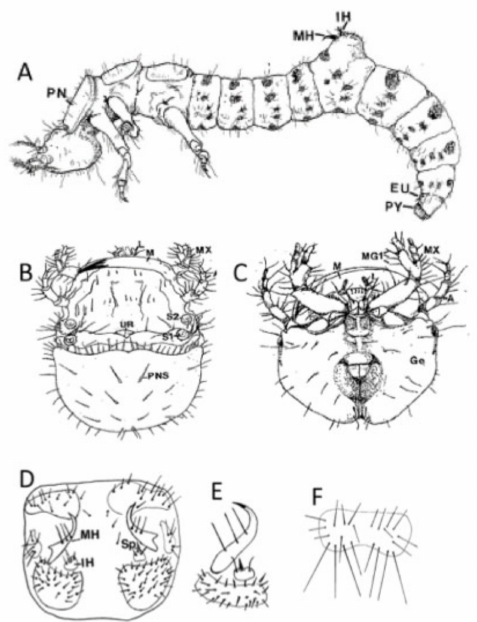
Figure 3. ( A ) Tiger beetle larva showing key characters: PN, pronotum; MN, median hooks; IH, inner hooks; EU, ninth eusternum; PY, pygopod. ( B ) Head, dorsal view, ( C ) ventral view: M, mandible; S1, stemmata I; S2, stemmata II; U, U-shaped ridge of frons; PNS, pronotal setae; MG1, galea of maxilla (for determining instar); MX, maxilla; A, antenna; Ge, gena; L, labium. ( D ) Dorsal view of fifth abdominal segment showing hooks Nin, sclerites, and setae. ( E ) Median and inner hooks and fifth caudal sclerite. ( F ) Ninth eusternum showing two groups of four